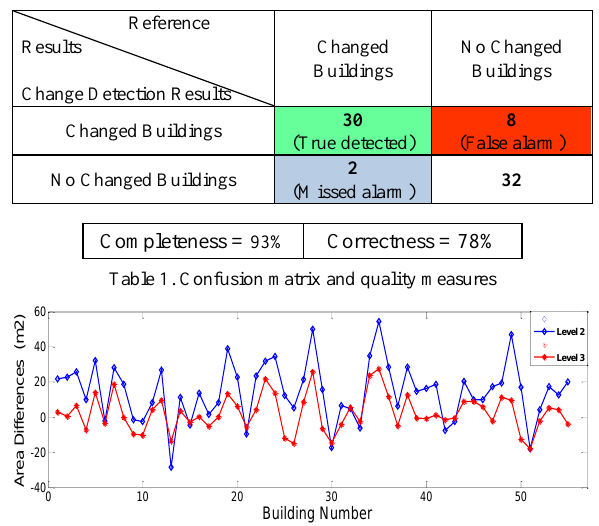
Figure 9. Difference between area of reference polygons and correspond correct extracted buildings outline in levels 2 and